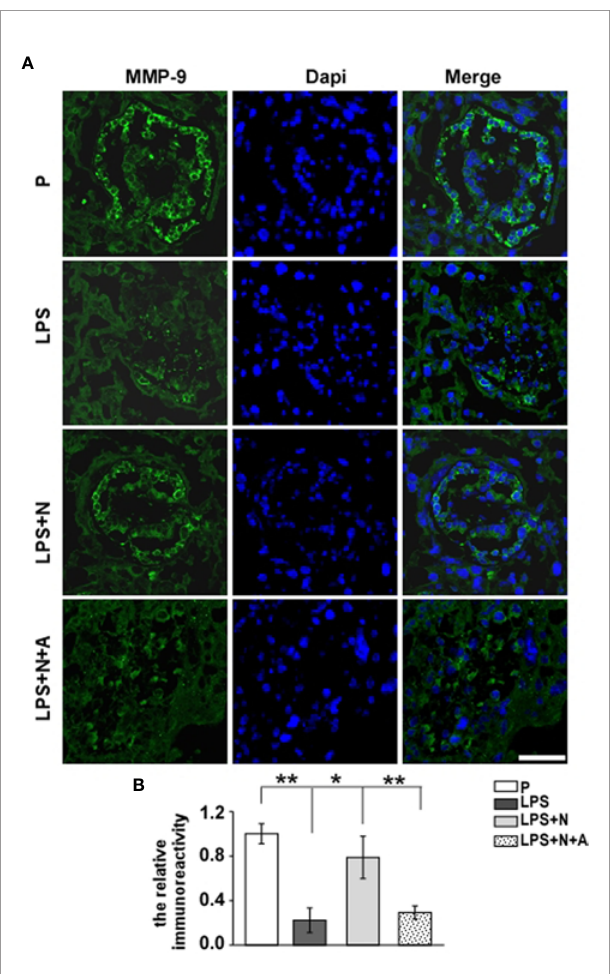
FIGURE 4 | Nicotine up-regulated the decreased MMP-9 expression in placentas from LPS-induced PE-like mice. Representative immuno fl uorescent images (A) and graph bar (B) showed changes in levels of MMP-9 immunoreactivity (green) in the trophoblast layer of placentas from all animal groups. Scale bar=50 m m. *P < 0.05 and **P < 0.01.